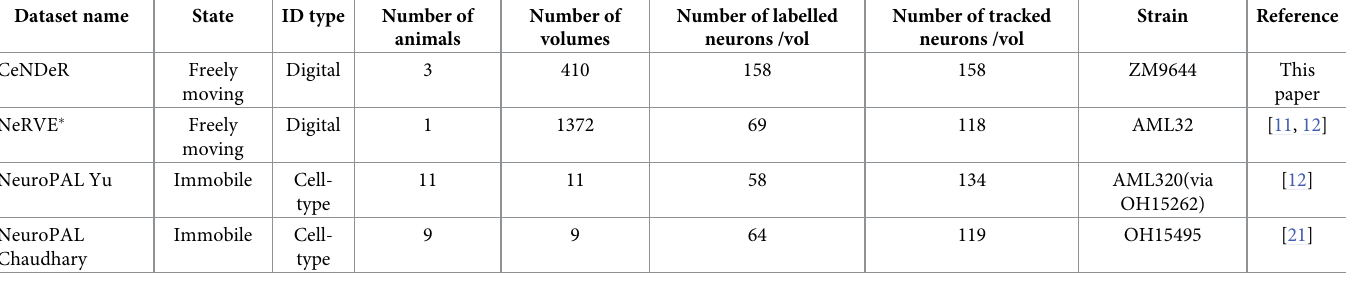
Table 3. Description of all Datasets. All datasets used to train or test CeNDeR throughout this paper. The definition of Digital or Cell-type ID could be found in Digital ID, cell-type ID, and human annotation.